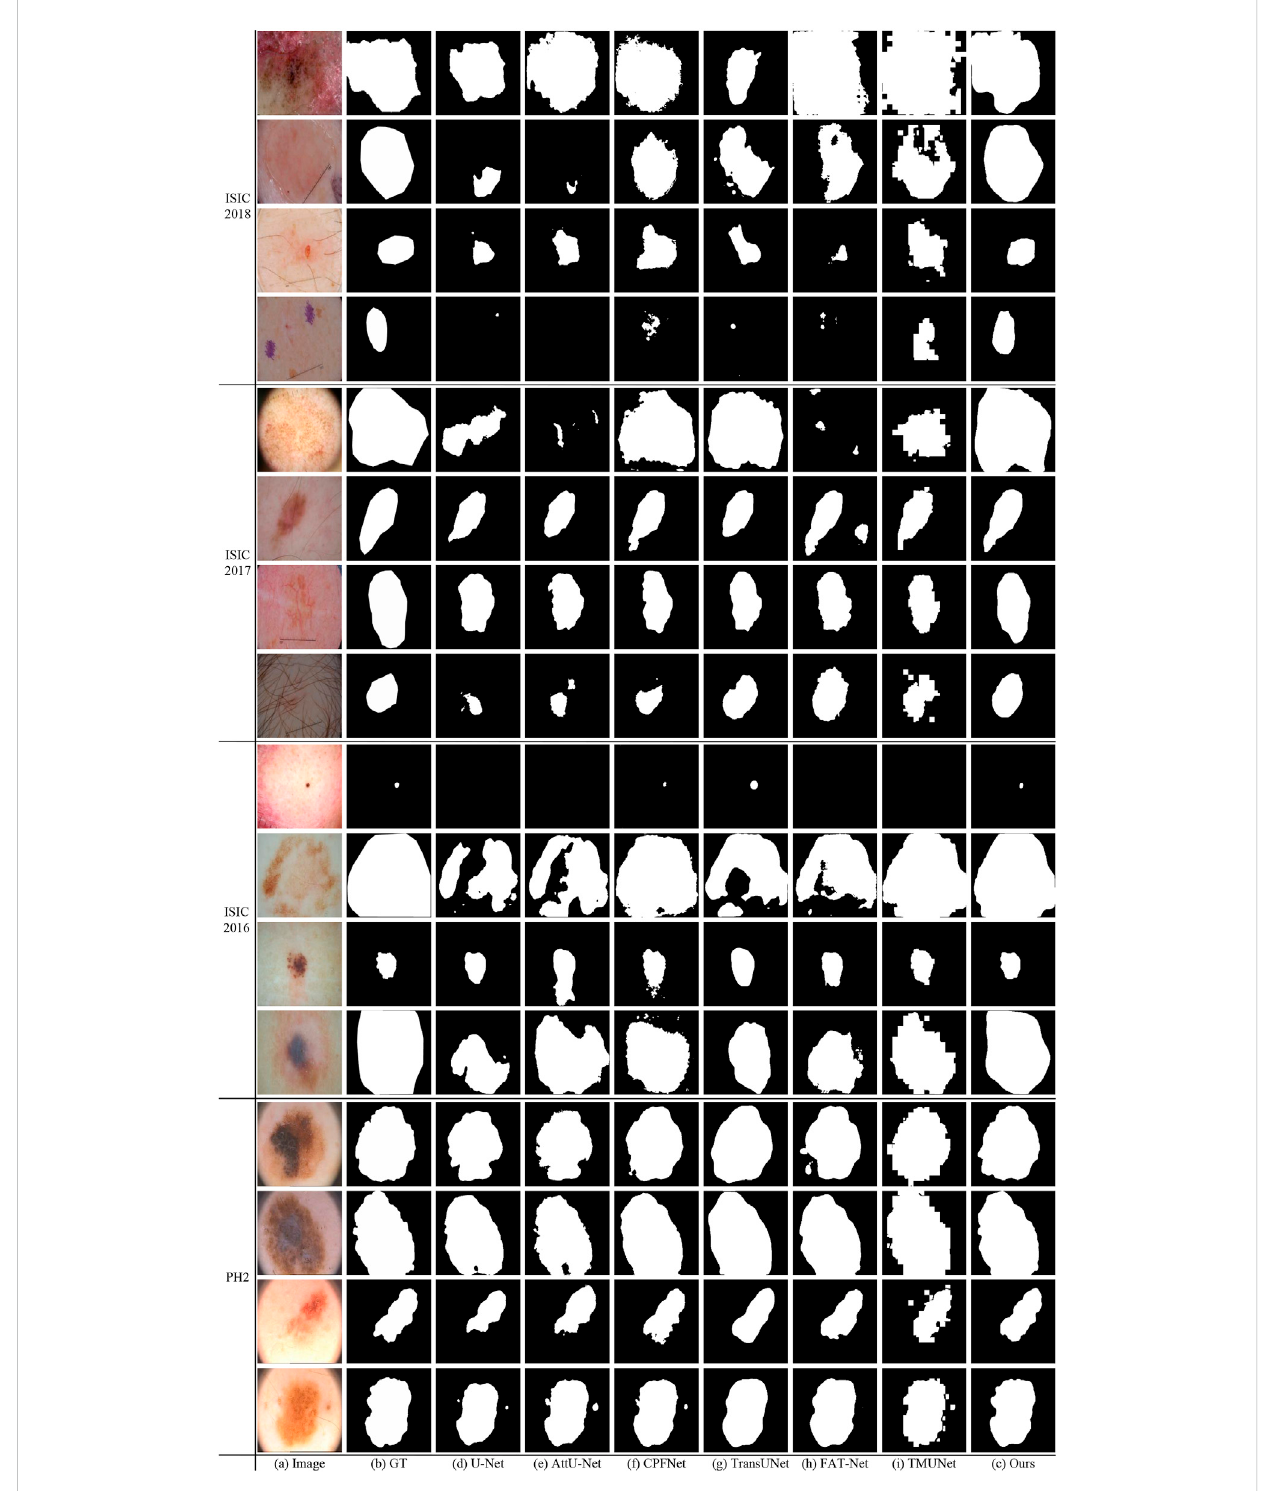
FIGURE 10 Visual comparison of the segmentation results on ISIC 2018, ISIC 2017, ISIC2016 and